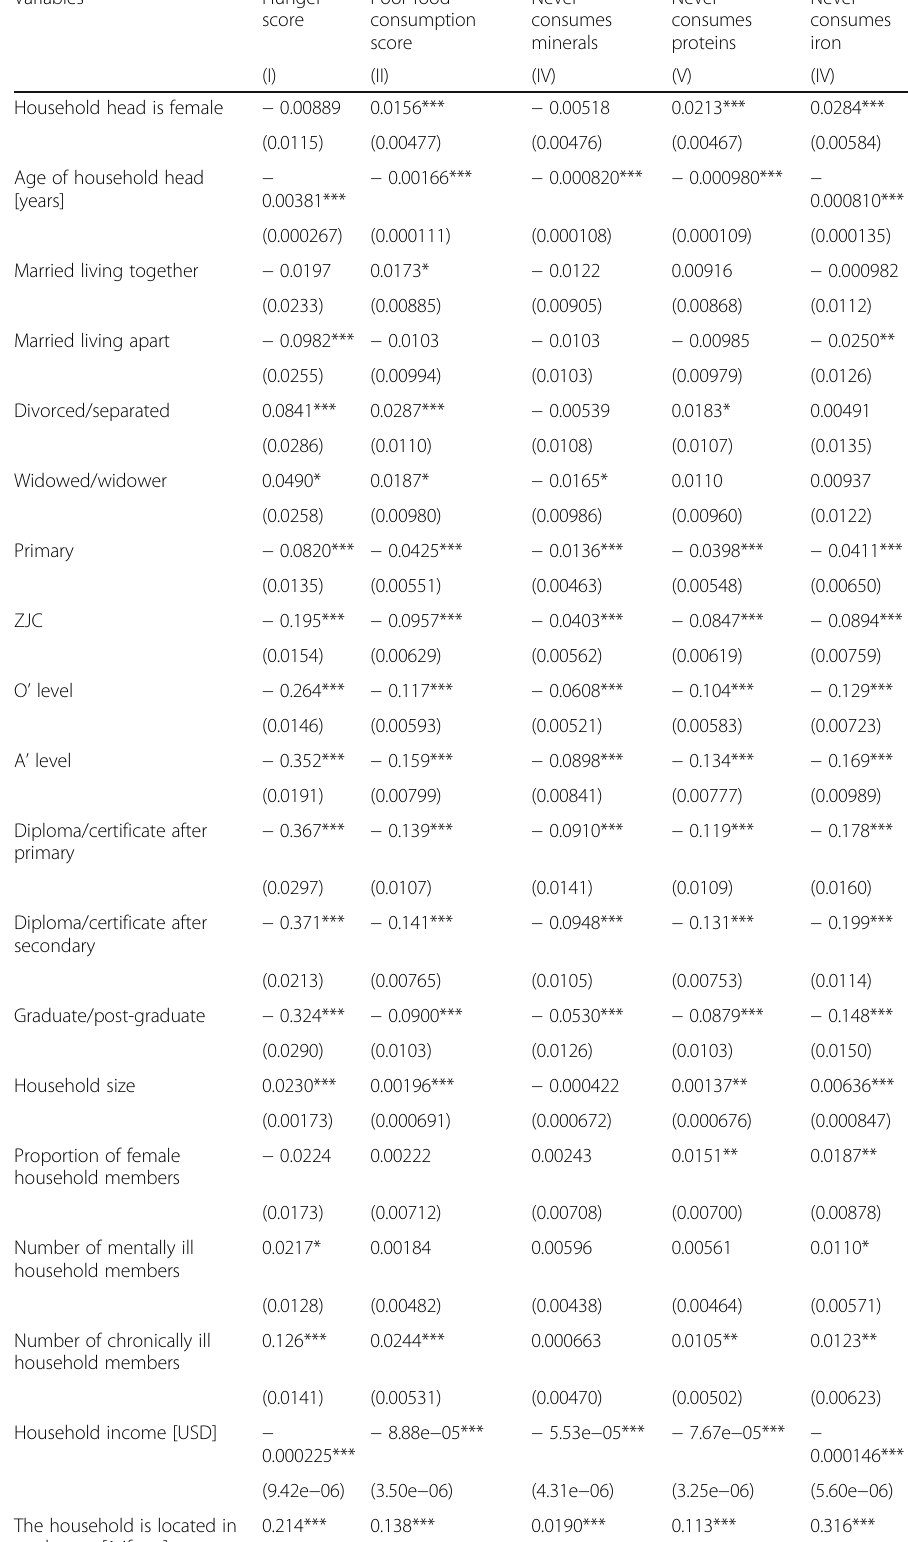
Table 5 OLS estimates of the impact of gender on food